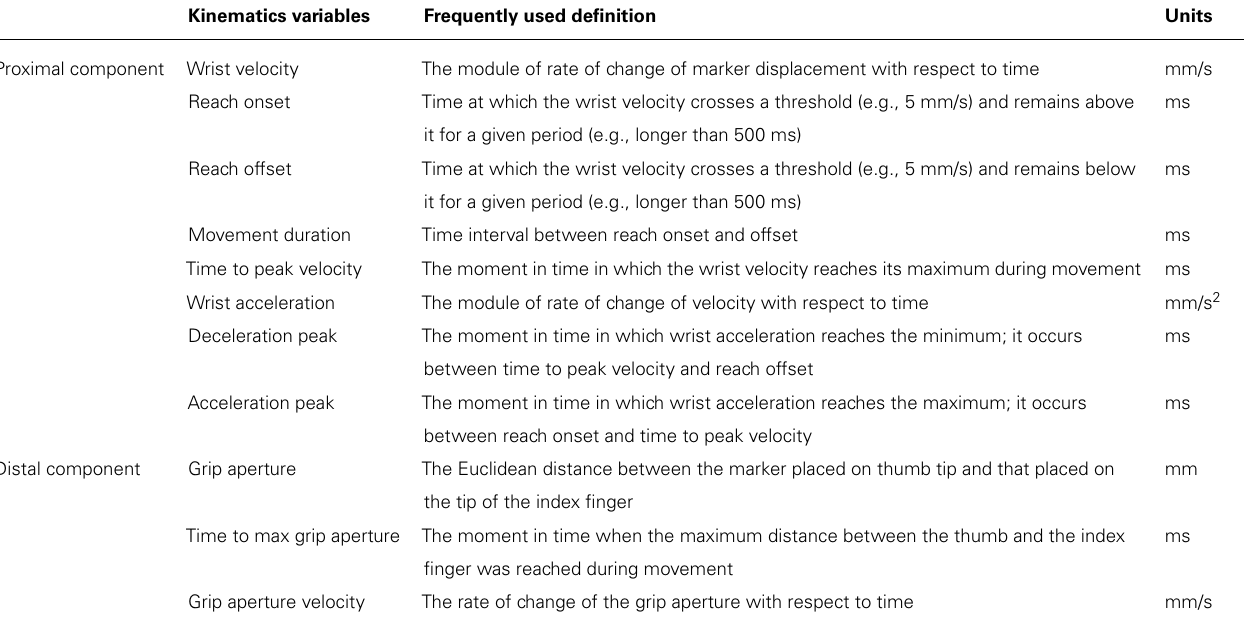
Table 1 |A brief overview of the main kinematic variables traditionally used to describe reach-to-grasp